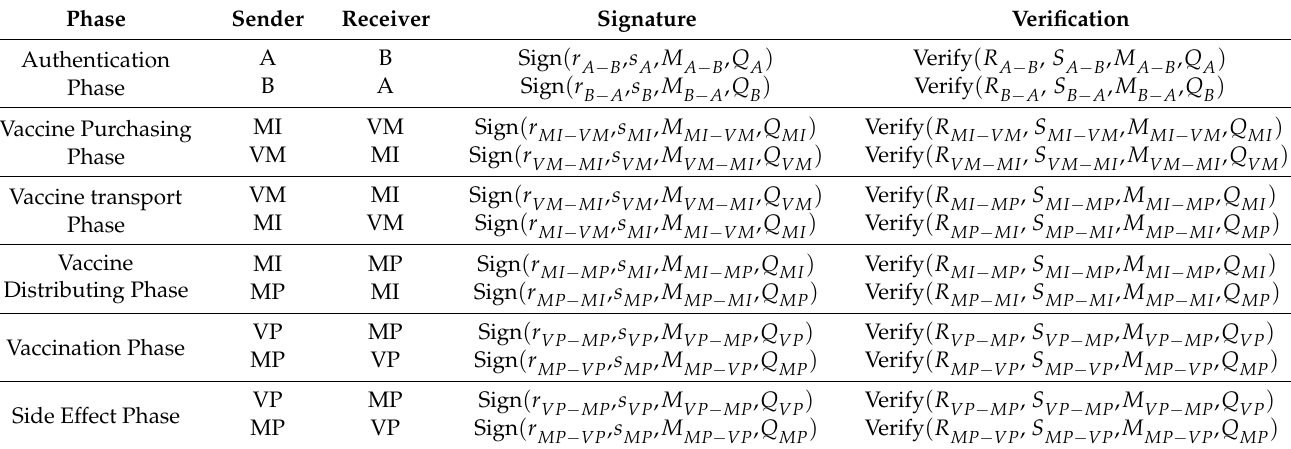
Table 1. Verification of integrity and non-repudiation in the proposed